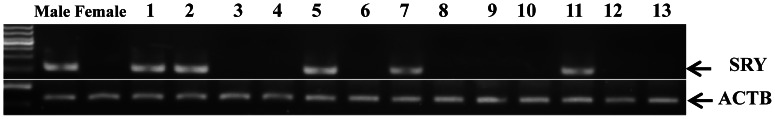
Sexing of IVF embryos.Porcine SRY gene specific nested primers were designed to distinguish the sex of IVF embryos.